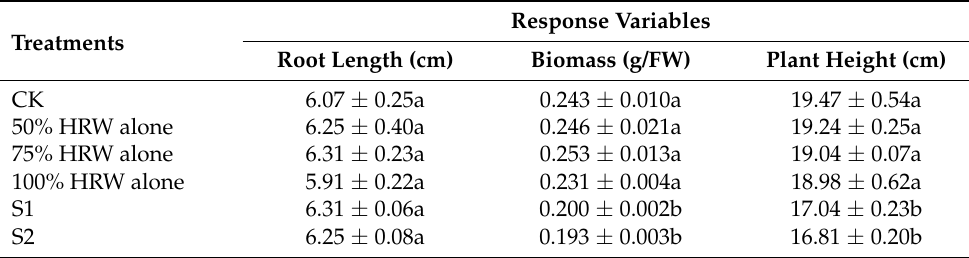
Table 1. Effects of the herbicide BS (Bispyribac-sodium) and HRW (hydrogen-rich water) on root length, biomass, and plant height of indica rice (at five days post treatment).